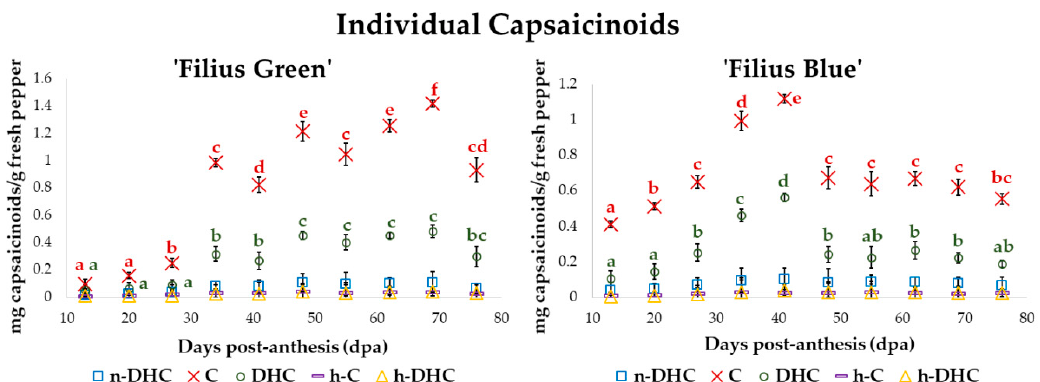
Figure 3. Individual capsaicinoids concentrations (mg g − 1 fresh pepper (FW)) over the fruit ripening process ( n = 2). The same letter indicates that no significant di ff erence according to Tuckey’s test were observed, that is, both values have a p -value > 0.05. In addition, a di ff erent letter color has been assigned to each specific capsaicinoid, i.e., blue for nordihydrocapsaicin (n-DHC), red for capsaicin (C), green for dihydrocapsaicin (DHC), purple for homocapsaicin (h-C), and yellow for homodihydrocapsaicin (h-DHC). Significant di ff erences in the two major compounds have highlighted to improve readability.